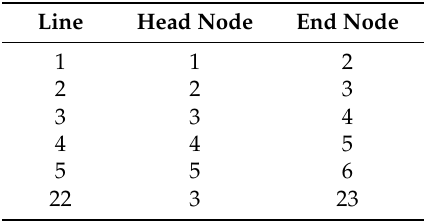
Table 1. Relationship between line number and node number.